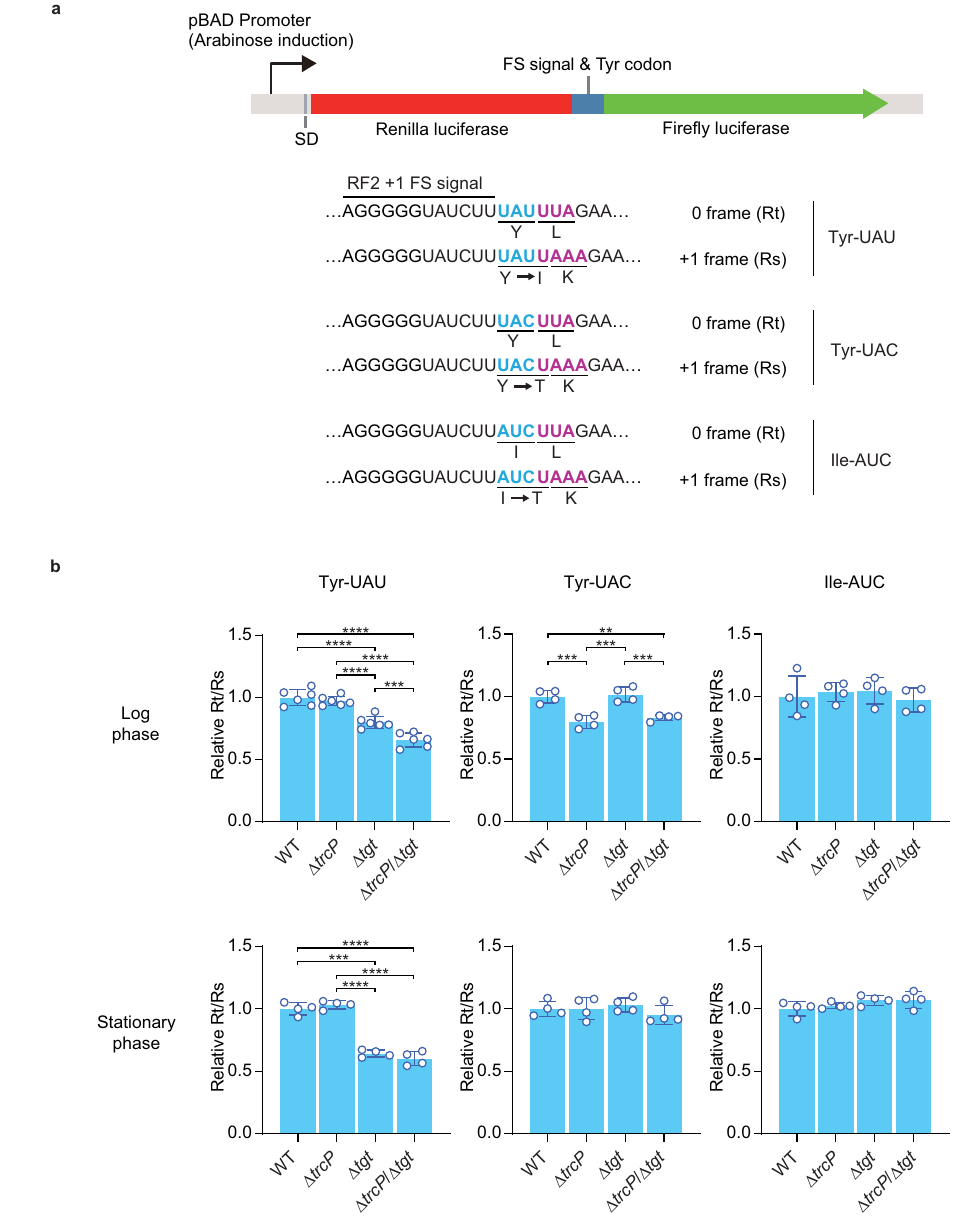
Fig.6|C-to- Ψ editingfacilitatesTyrdecoding.a Schematicofreporterconstruct for measuring decoding ability of tRNA-Tyr and tRNA-Ile. b Reporter assays eval- uating decoding of Tyr and Ile codons. Relative Rt/Rs value (see methods) is indi- cated.Thetopandbottompanelsshowtheresultsderivedfromlogandstationary phase cultures, respectively. The tested codons are shown above, and the tested strains are labeled below. Ordinary one-way ANOVA was used for a statistical